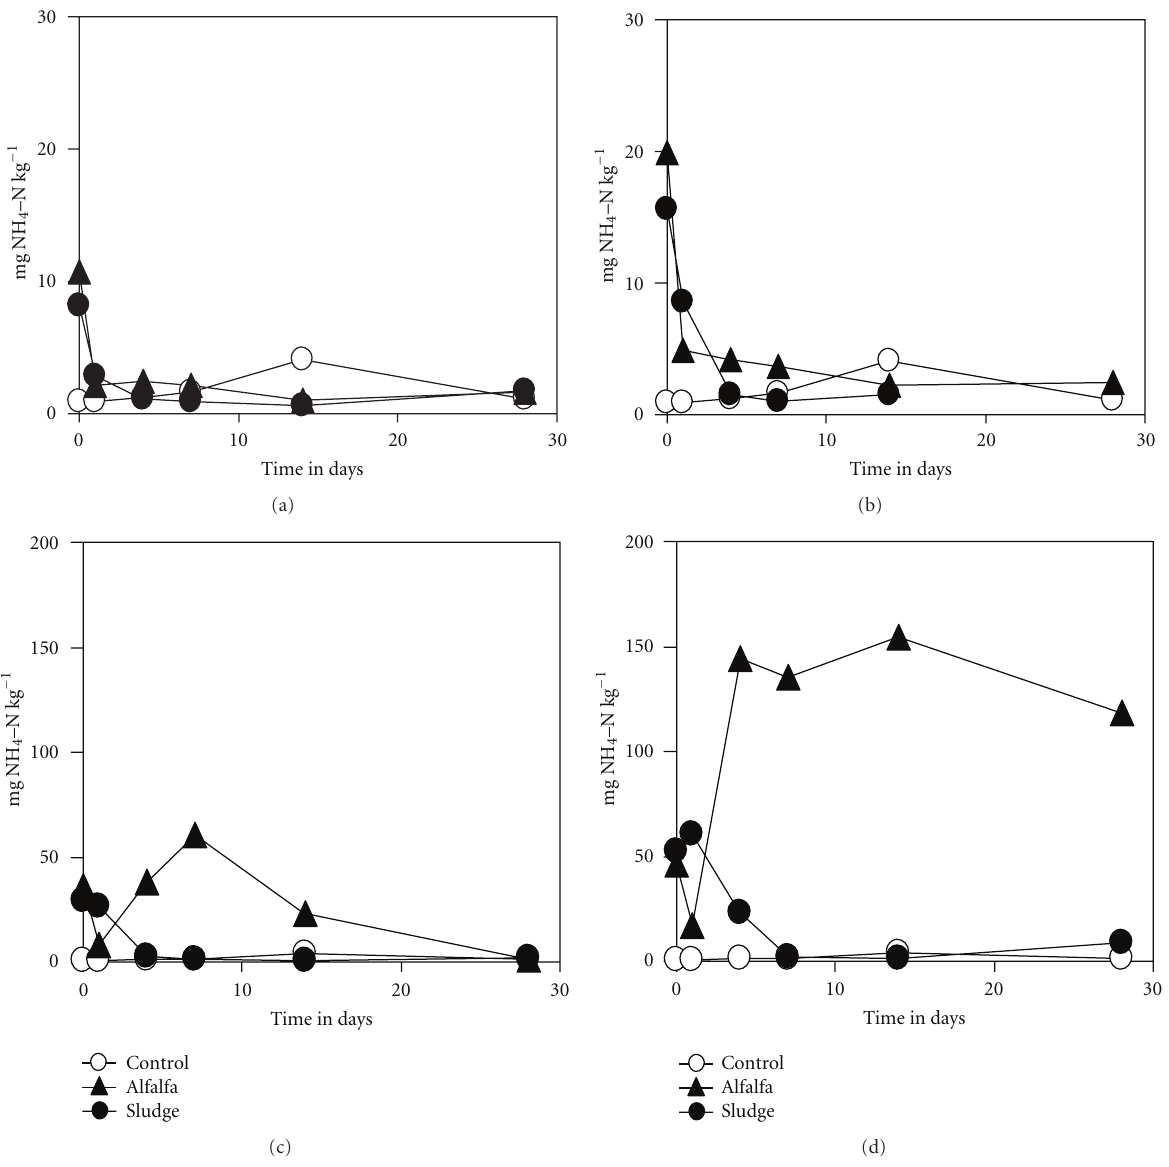
Figure 1: Incubation experiment one. Changes with time for ammonium extracted from incubations of sludge and alfalfa with soil at rates of (a) 100, (b) 200, (c) 400, and (d) 800mgN kg − 1 dry soil. Controls received no